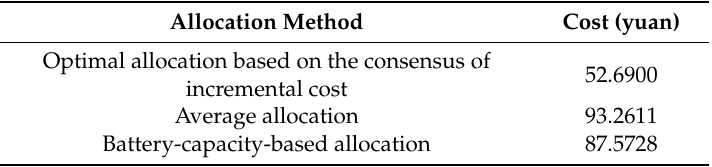
Table 6. The life loss cost of batteries under different allocation methods.